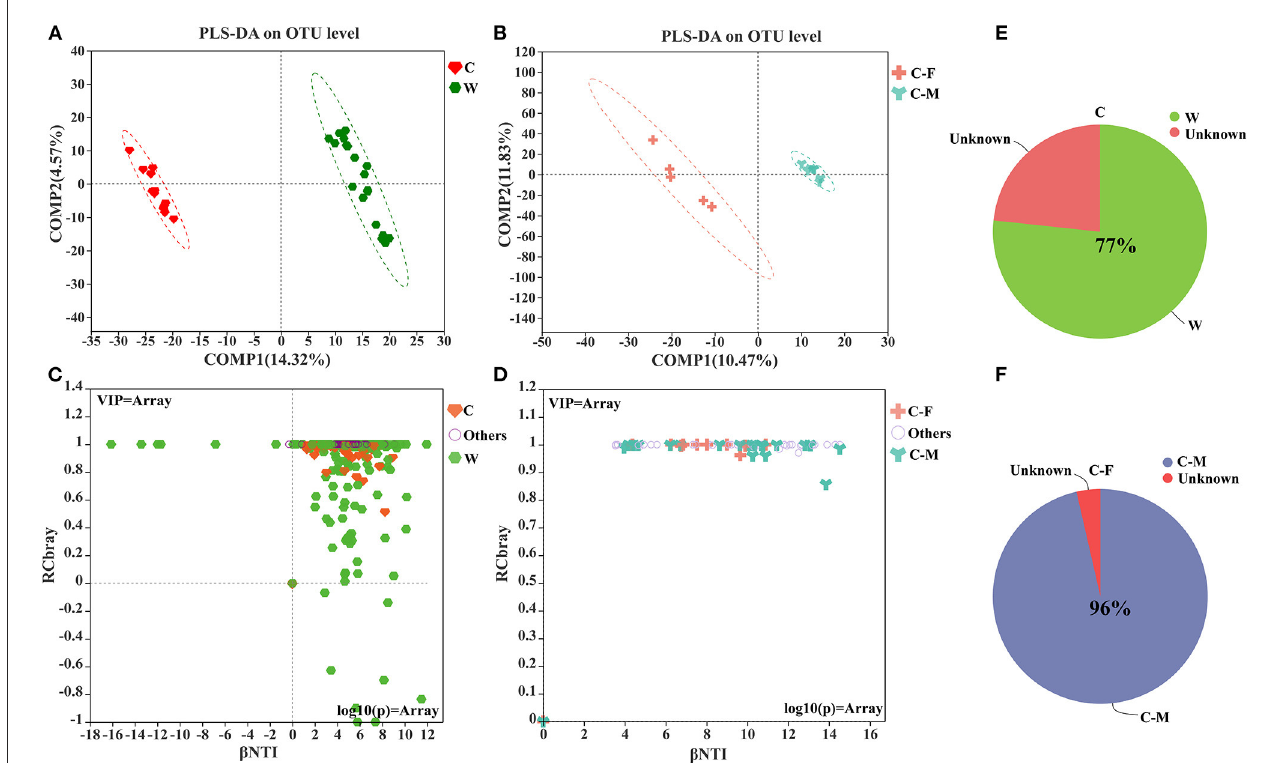
FIGURE2 (A, B) Partial least squares-discriminant analysis (PLS-DA) of microbial communities for each group; (C, D) Microbial community assembly or community structure by β NTI/RCbray; (E, F) Pie charts of the mean SourceTracker proportion estimates for 100 draws from Gibbs sampling in captive vs. wild groups and captivity between female and male groups (W: wild, C: captive, C-F: captive female, and C-M: captive male).